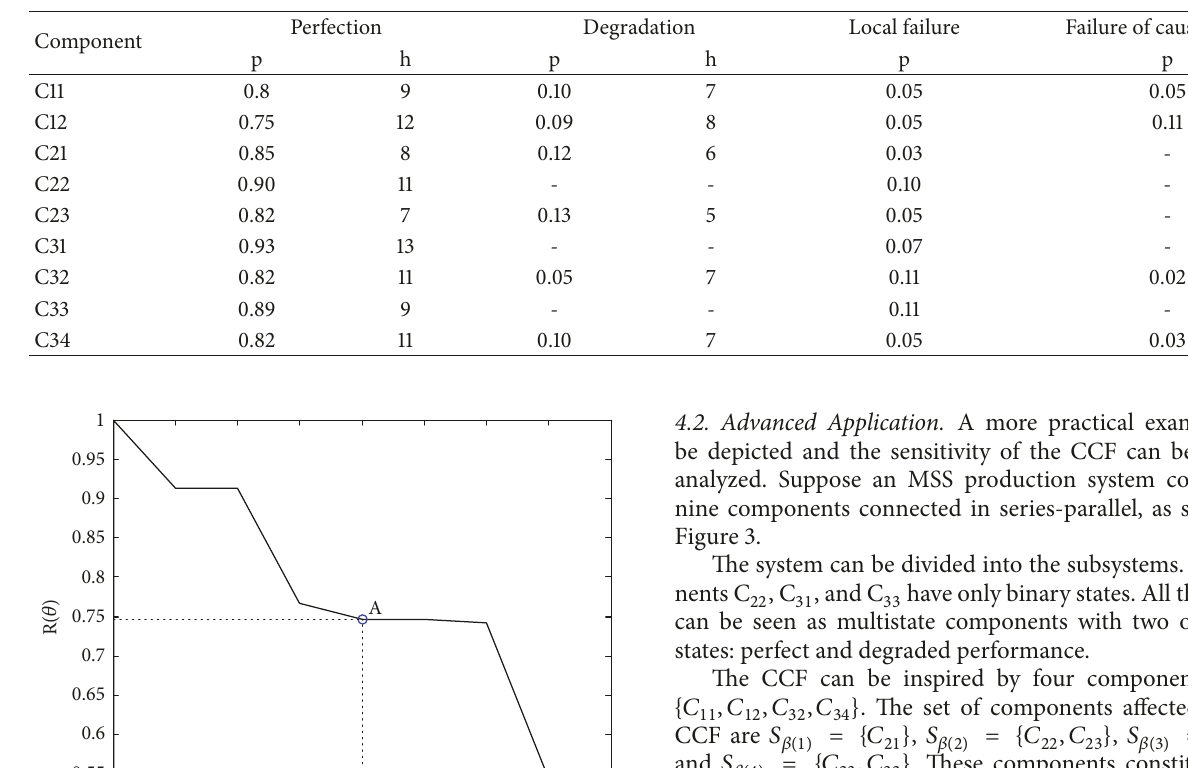
Table 3: Performance distribution of components.